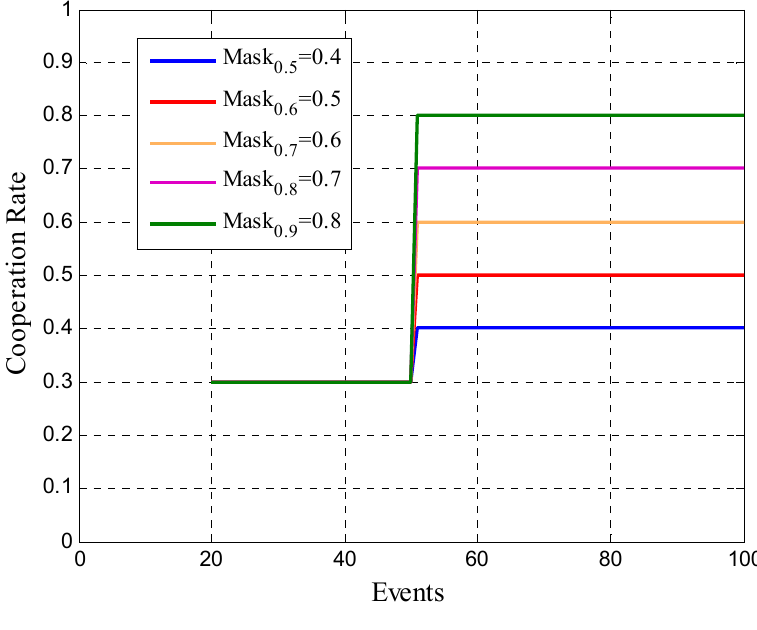
Figure 8. Removal Figure 8. Removal masks.